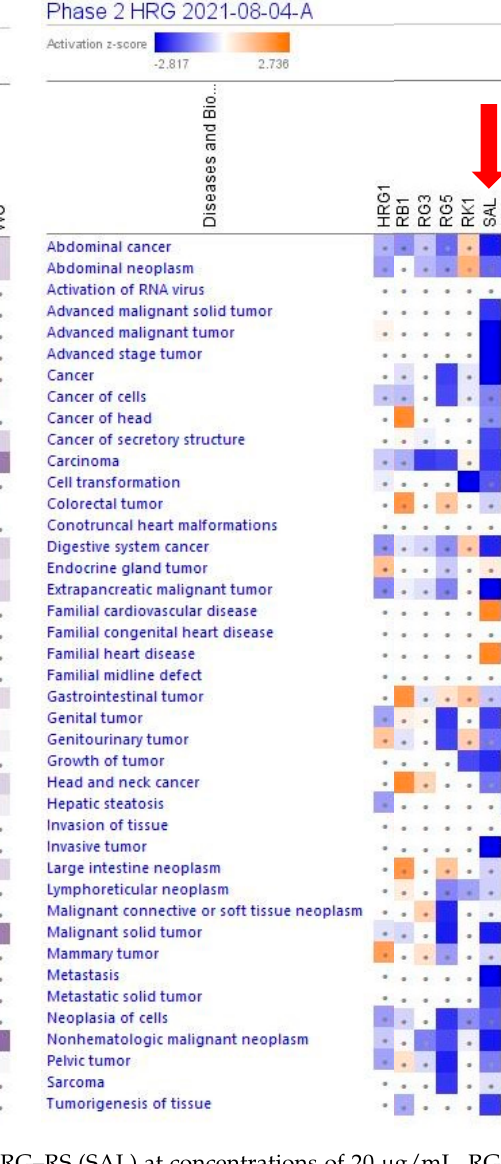
Figure 2. Effects of RG–RS (SAL) at concentrations of 20 μ g/mL, RG at concentrations of 10 μ g/mL